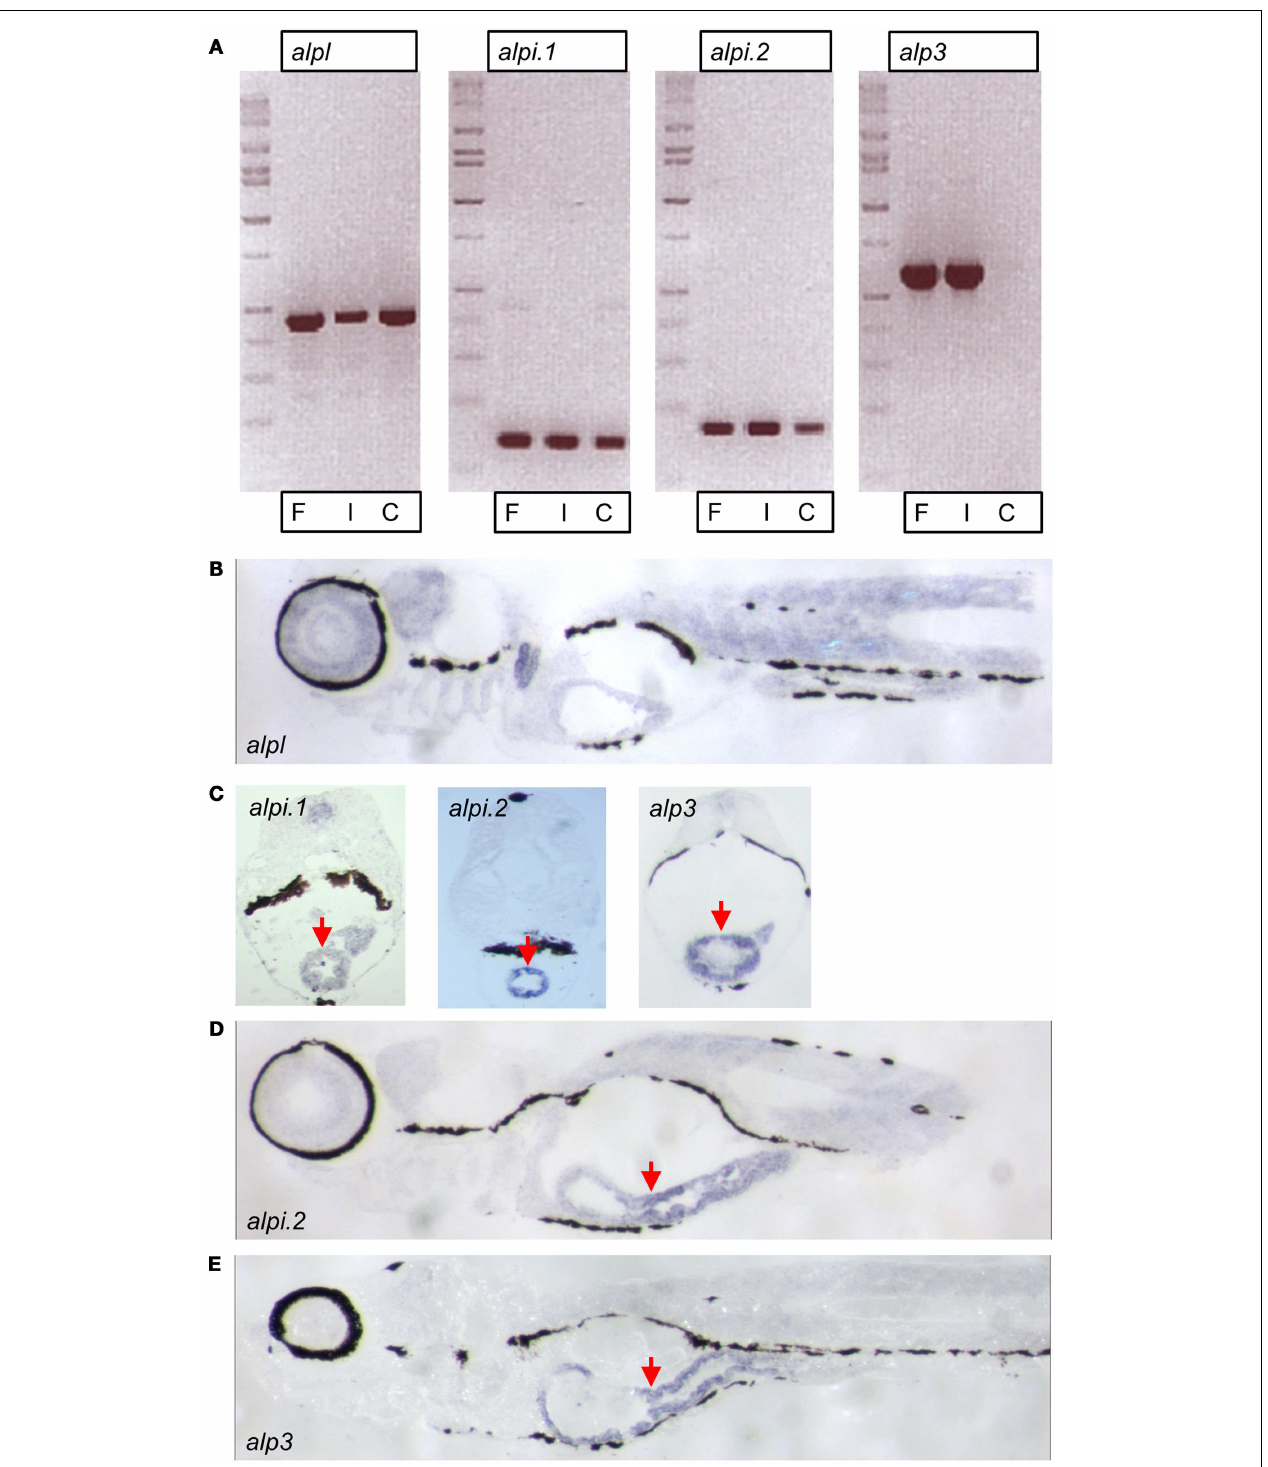
intestine removed (C). In situ hybridization of 7dpf larval sagittal (B,D,E) and transverse (C) sections with probes to alpl , alpi.1 , alpi.2 , and alp3 as indicated. The hybridization is visible in blue. Arrows point to the intestinal